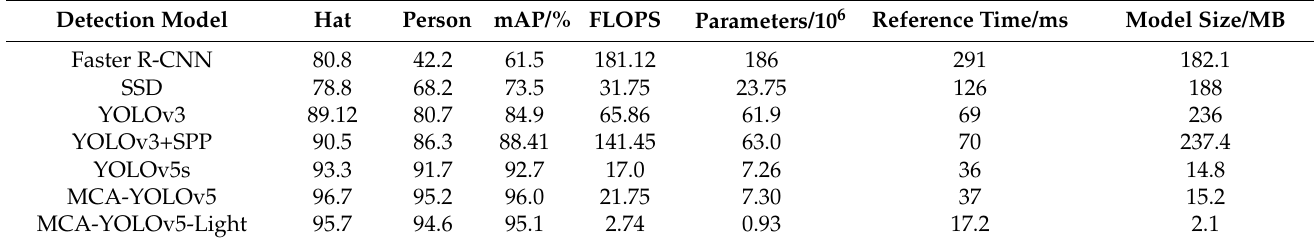
Table 4. Comparison of the test results for the different models (Our algorithm compared with other algorithms in terms of computational speed, model size, and